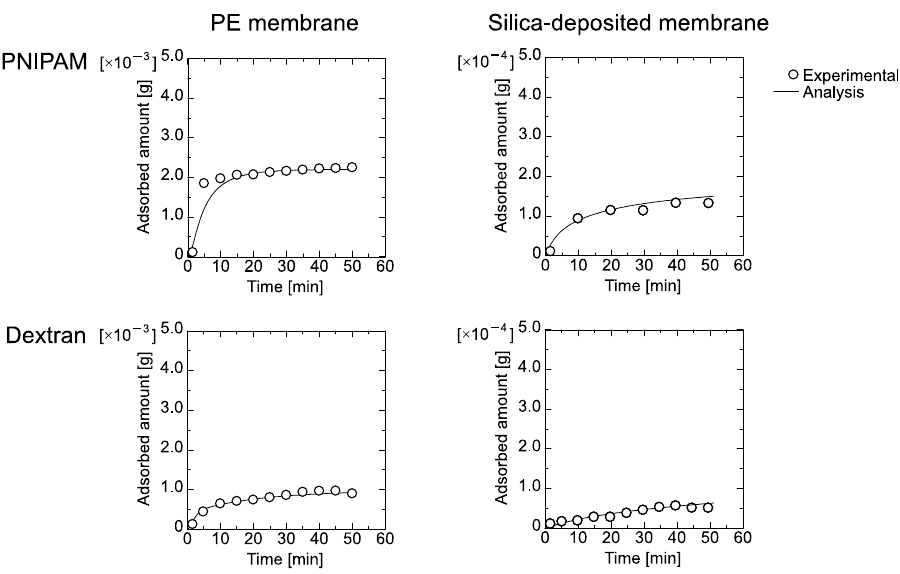
Figure 5. Time course curves of adsorbed amount of PNIPAM gel and dextran through PE and silica-deposited membranes.